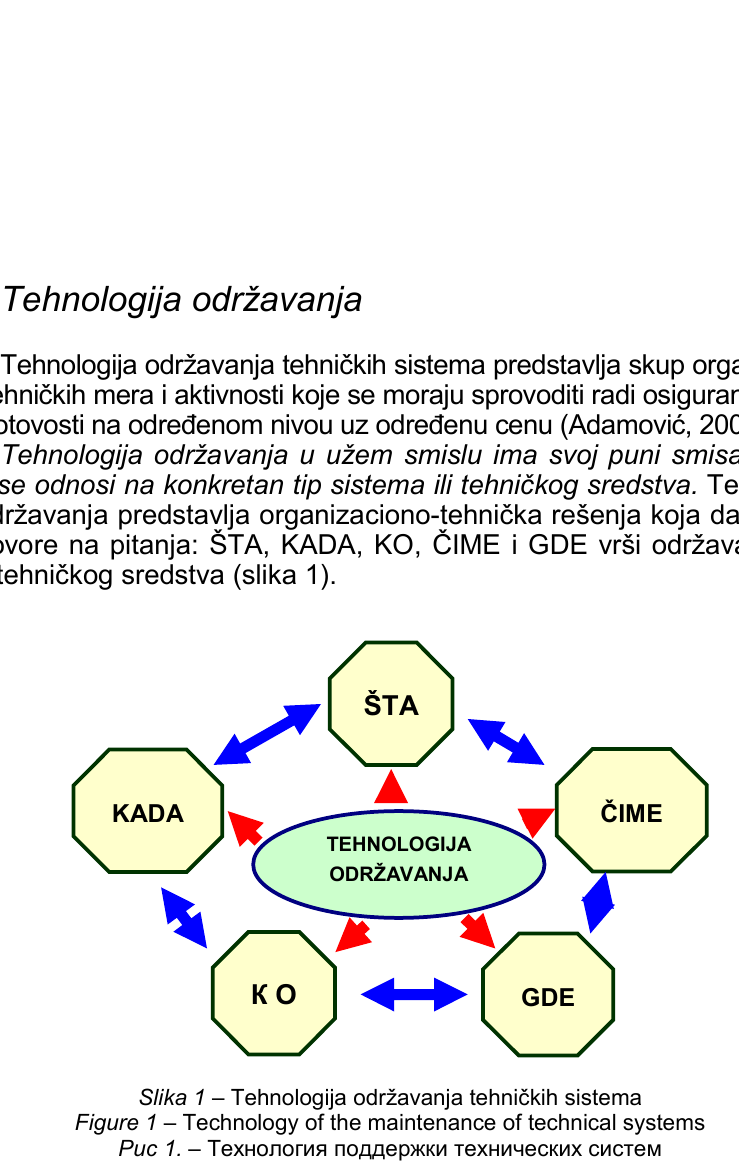
Рис 1. – Технология поддержки технических